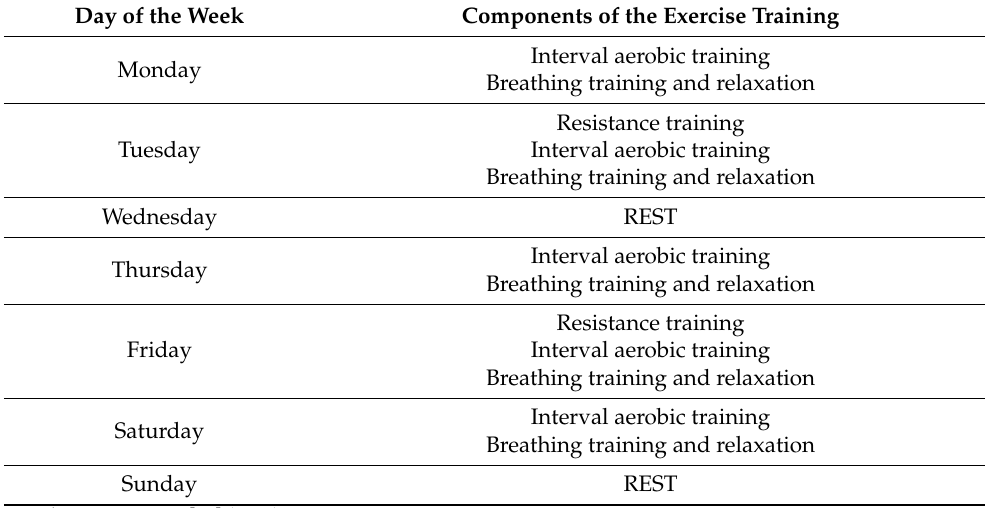
Table 2. Modified description of the exercise